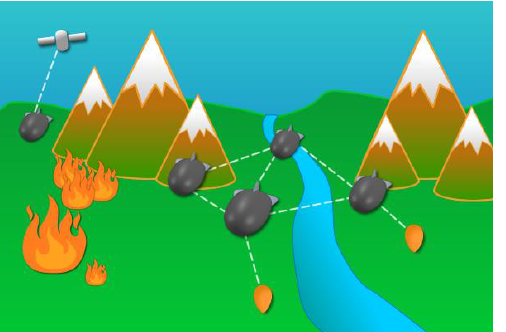
Figure 4. Temporary installation of a DNIHSS using ATAA deployed as needed.